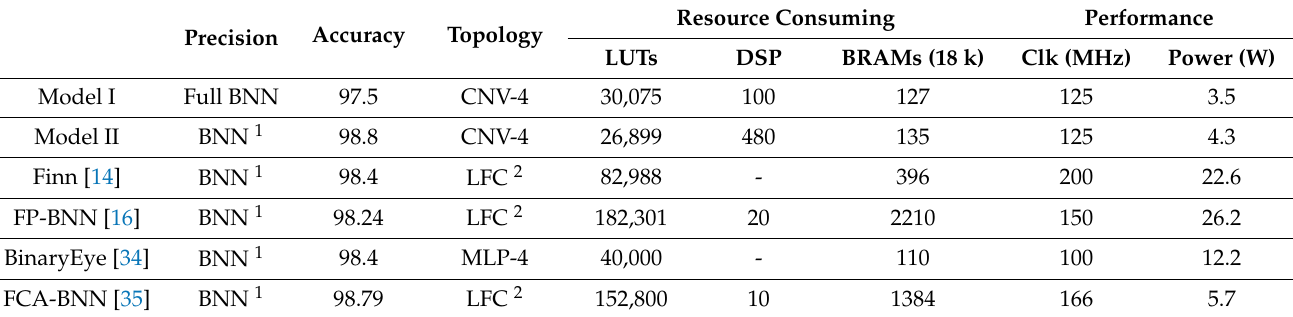
Table 4. Deployment performance of binary neural